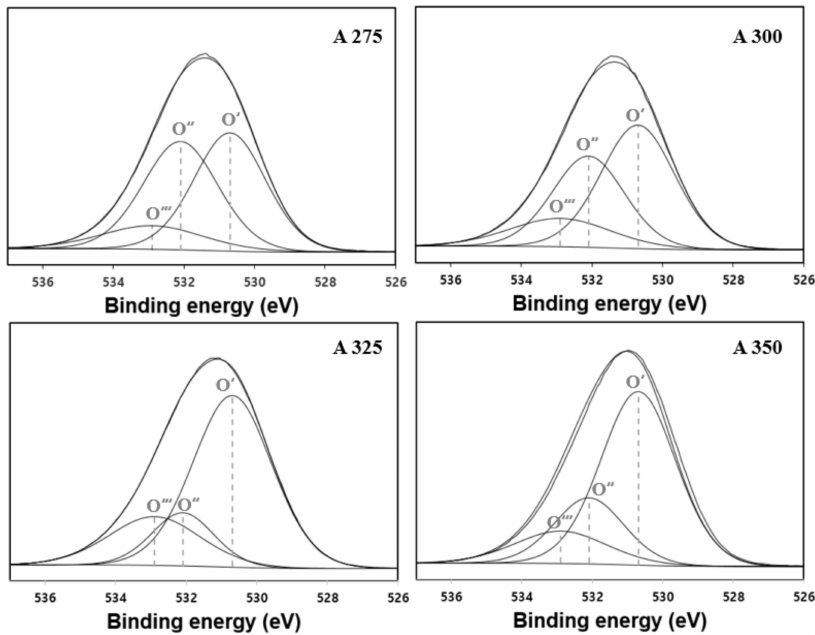
Figure 5. The XPS deconvolution results of O 1s of the alumina catalysts A275, A300, A325, and A350. Table 2. XPS data of Al 2p and O 1s of the alumina catalysts A275, A300, A325, and A350. Catalysts